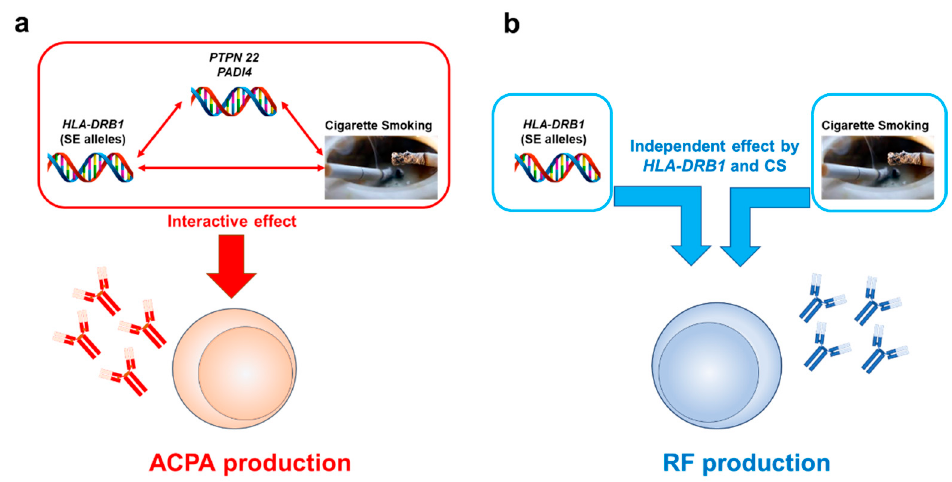
Figure 1. The differential effects of gene and environmental factors (cigarette smoking) on ACPA and RF production. The interactive effects of cigarette smoking (CS) and genetic components, especially HLA-DRB1 , contribute to ACPA production and subsequently predispose subjects to ACPA-positive RA development. PTPN22 and PADI4 are also implicated as additional genetic components ( a ). For RF production, an interactive effect between genetic and CS is much less clear; rather, they are independent risk factors ( b ).